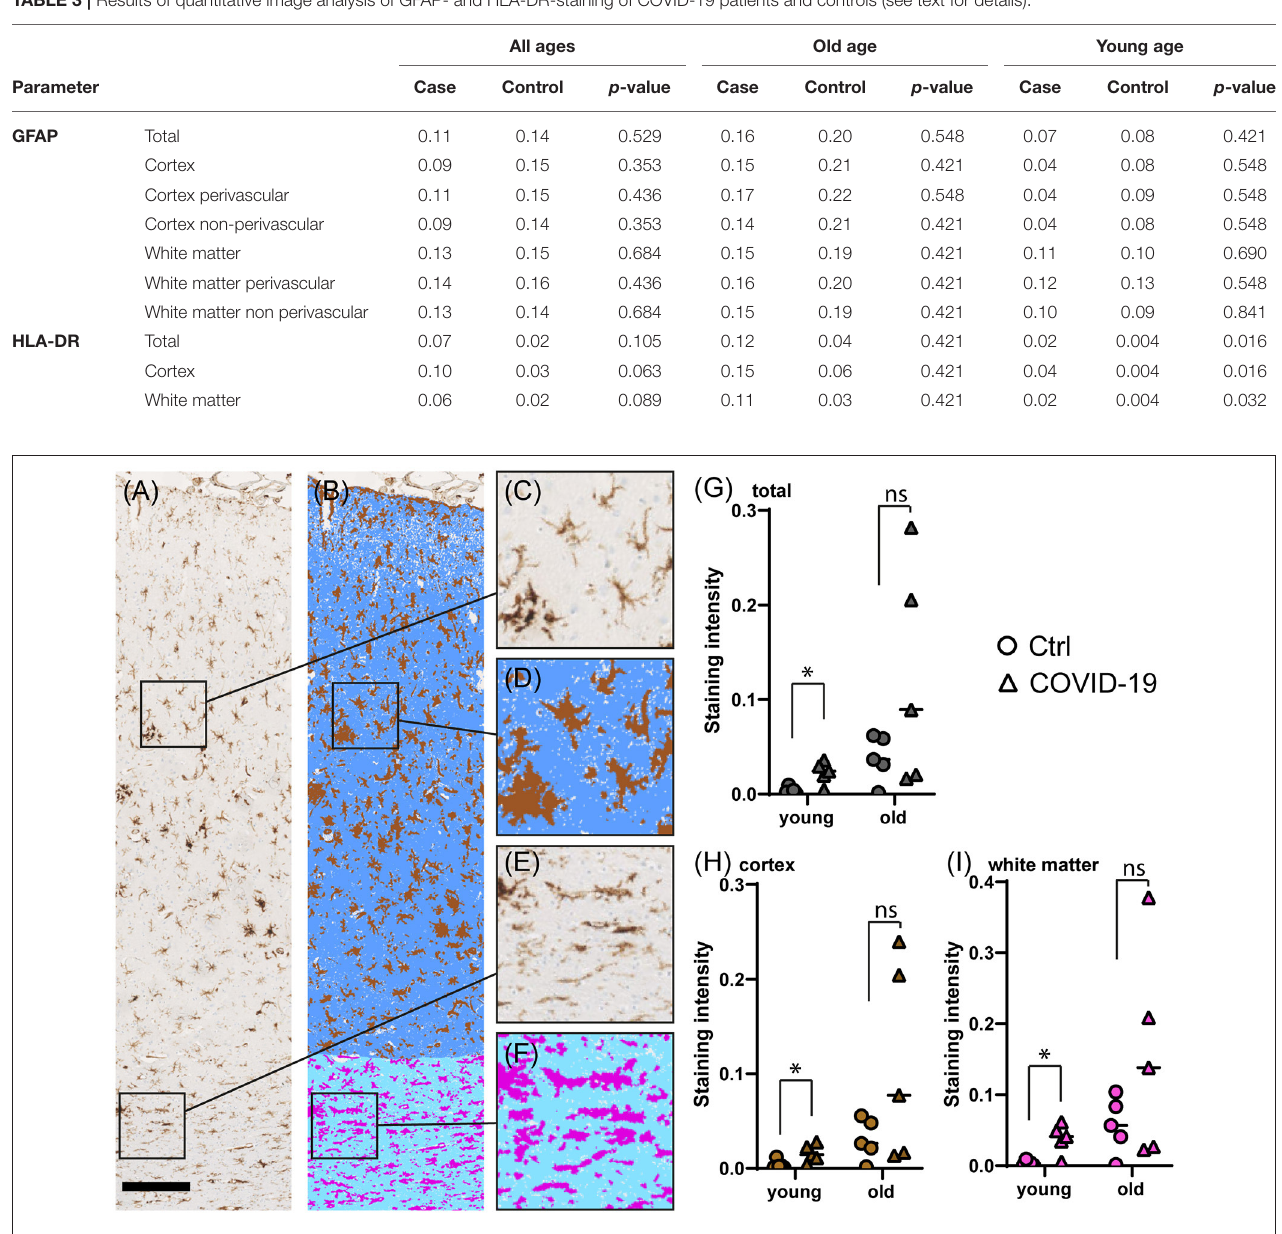
FIGURE 2 | Comparison of microglial marker HLA immunostaining in COVID-19- and control cerebral tissue stratified according to patient age at death. (A–F) Representative images of cerebral HLA immunostaining (A) , comprising cortex (C) and white matter (E) . The colorized overlay image (B) indicates categorized pixel intensities in the cortex [ (D) , brown: DAB, indigo: immunonegative tissue] and white matter [ (F) , magenta: DAB, sky blue: immunonegative tissue]. Scale bar is 250 µ m. (G–I) Dot plots showing staining intensity ratios calculated from cerebral tissue in young ( < 60y) vs. old ( ≥ 90y) patients in total (G) , and separately in the cortex (H) and white matter (I) . * p < 0.05, ns, not significant; n = 5 per